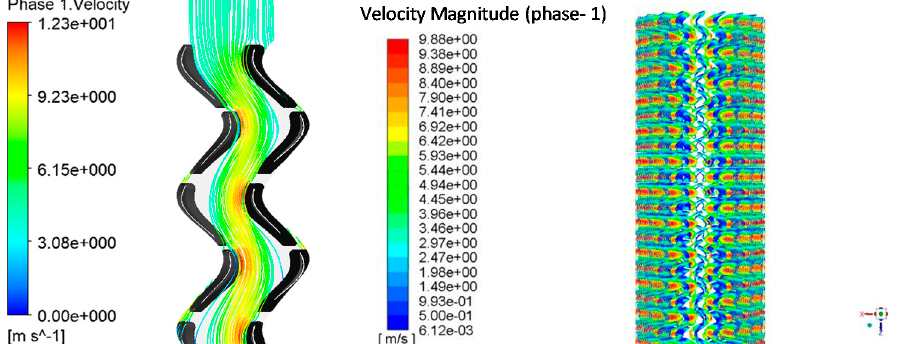
Figure 7. Streamline diagram of single − blade multi − stage turbodrill blades.